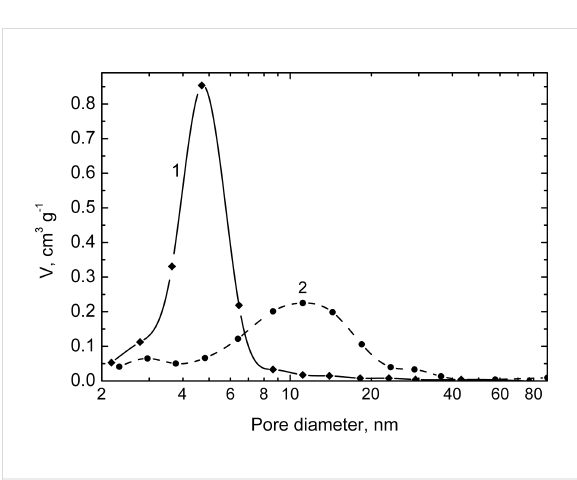
Figure 3: Barrett–Joyner–Halenda desorption-model pore-volume distribution of the In 2 O 3 (400) mesoporous films prepared with (1) and without (2) Pluronic F127.